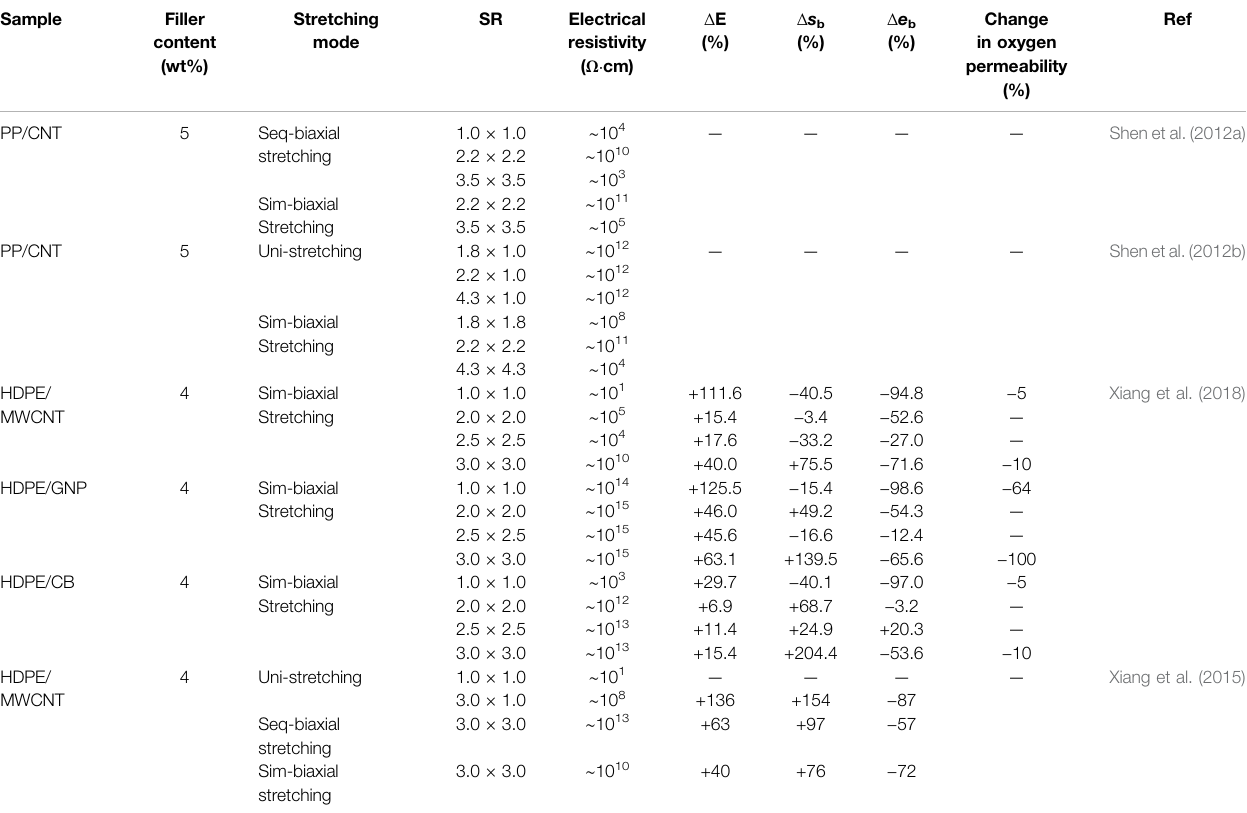
TABLE 1 | Effect of carbon nano fi llers on the mechanical,electrical, and barrier propertiesof uniaxially, seq-biaxially, and sim-biaxially stretched polymeric nanocomposites. Sample Filler